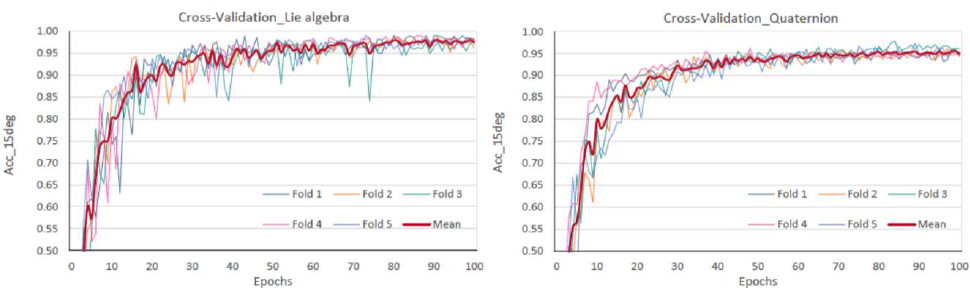
Figure 4. 5-fold cross validation: Lie algebra ( left ) and quaternion representation ( right ).